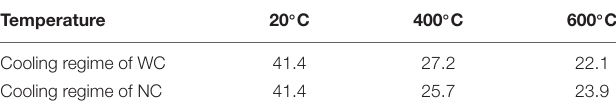
TABLE 2 | Compressive strength of RAC (MPa).